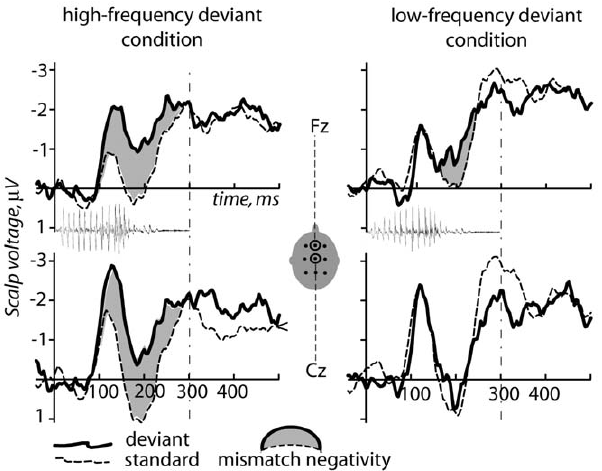
Figure 3. Mismatch negativity (MMN): deviant-standard differ- ence curves for the high- and low-frequency deviant condi- tions. Note the more pronounced MMN for the high-frequency word and a smaller MMN for its low-frequency